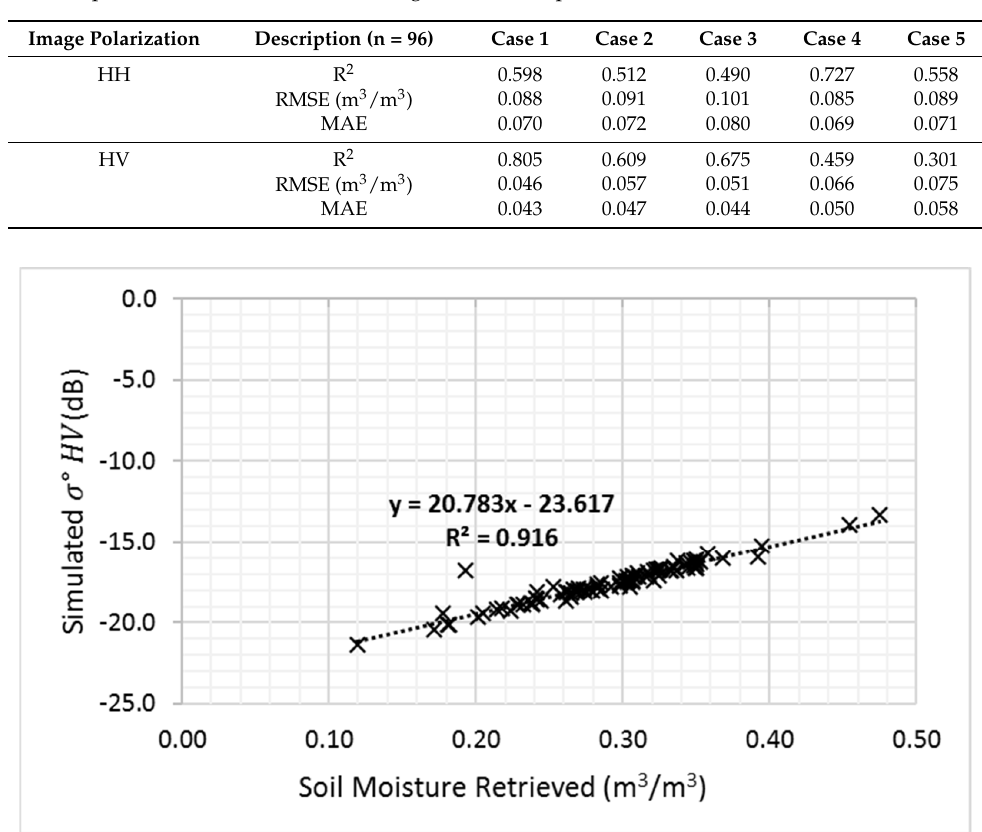
Table 6. Comparison between statistical parameters of retrieved and observed soil moisture for HH and HV polarization in relation to the vegetation descriptors.